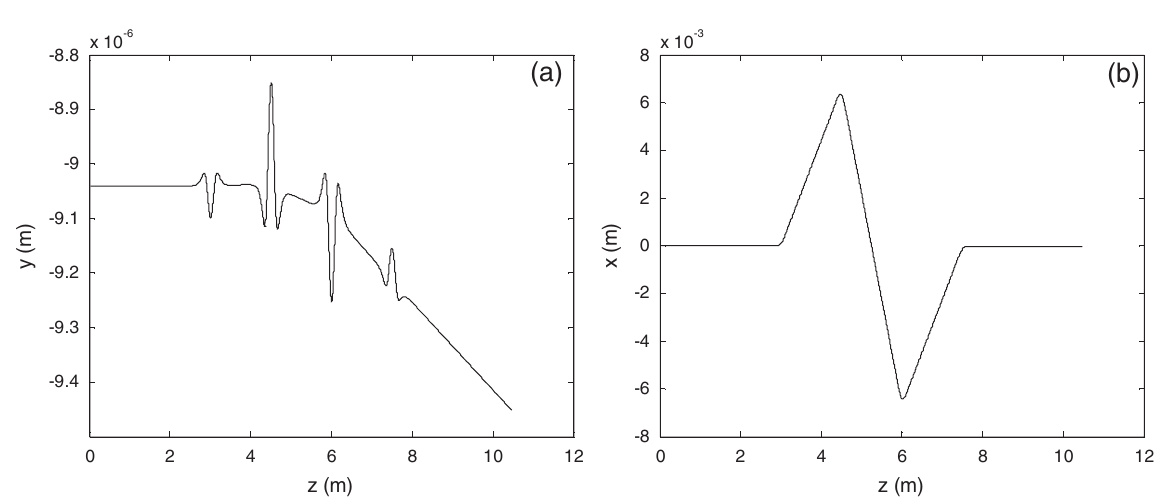
FIG. 5. Geometry of simulation in Sec. IVA.